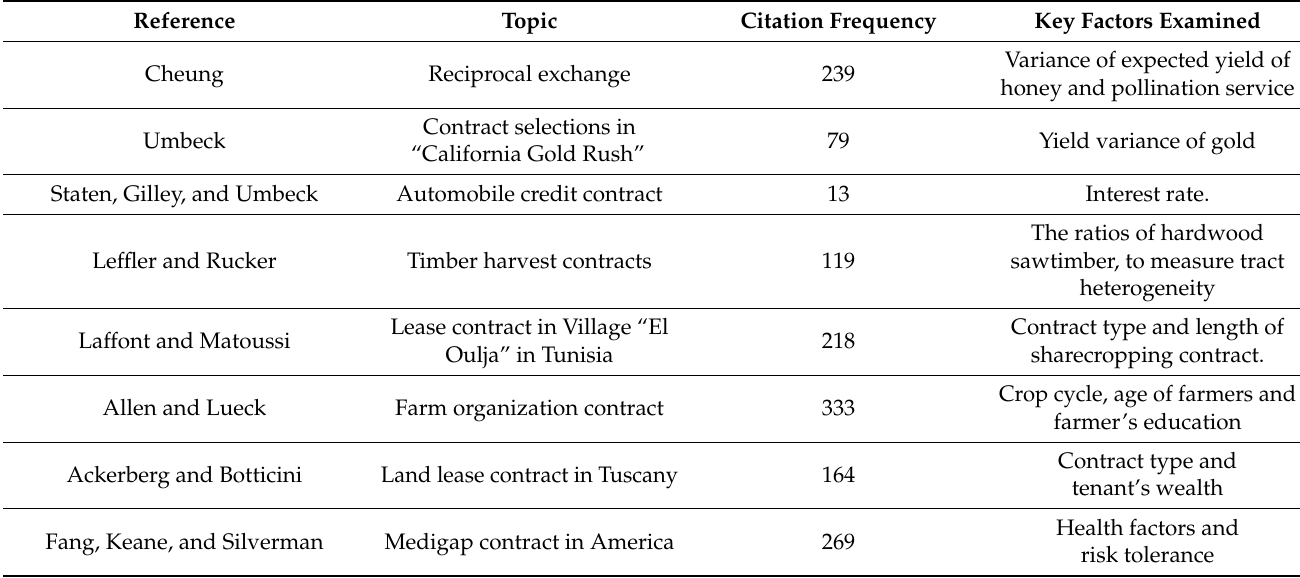
Table 1. Factors examined in Cheungian research on